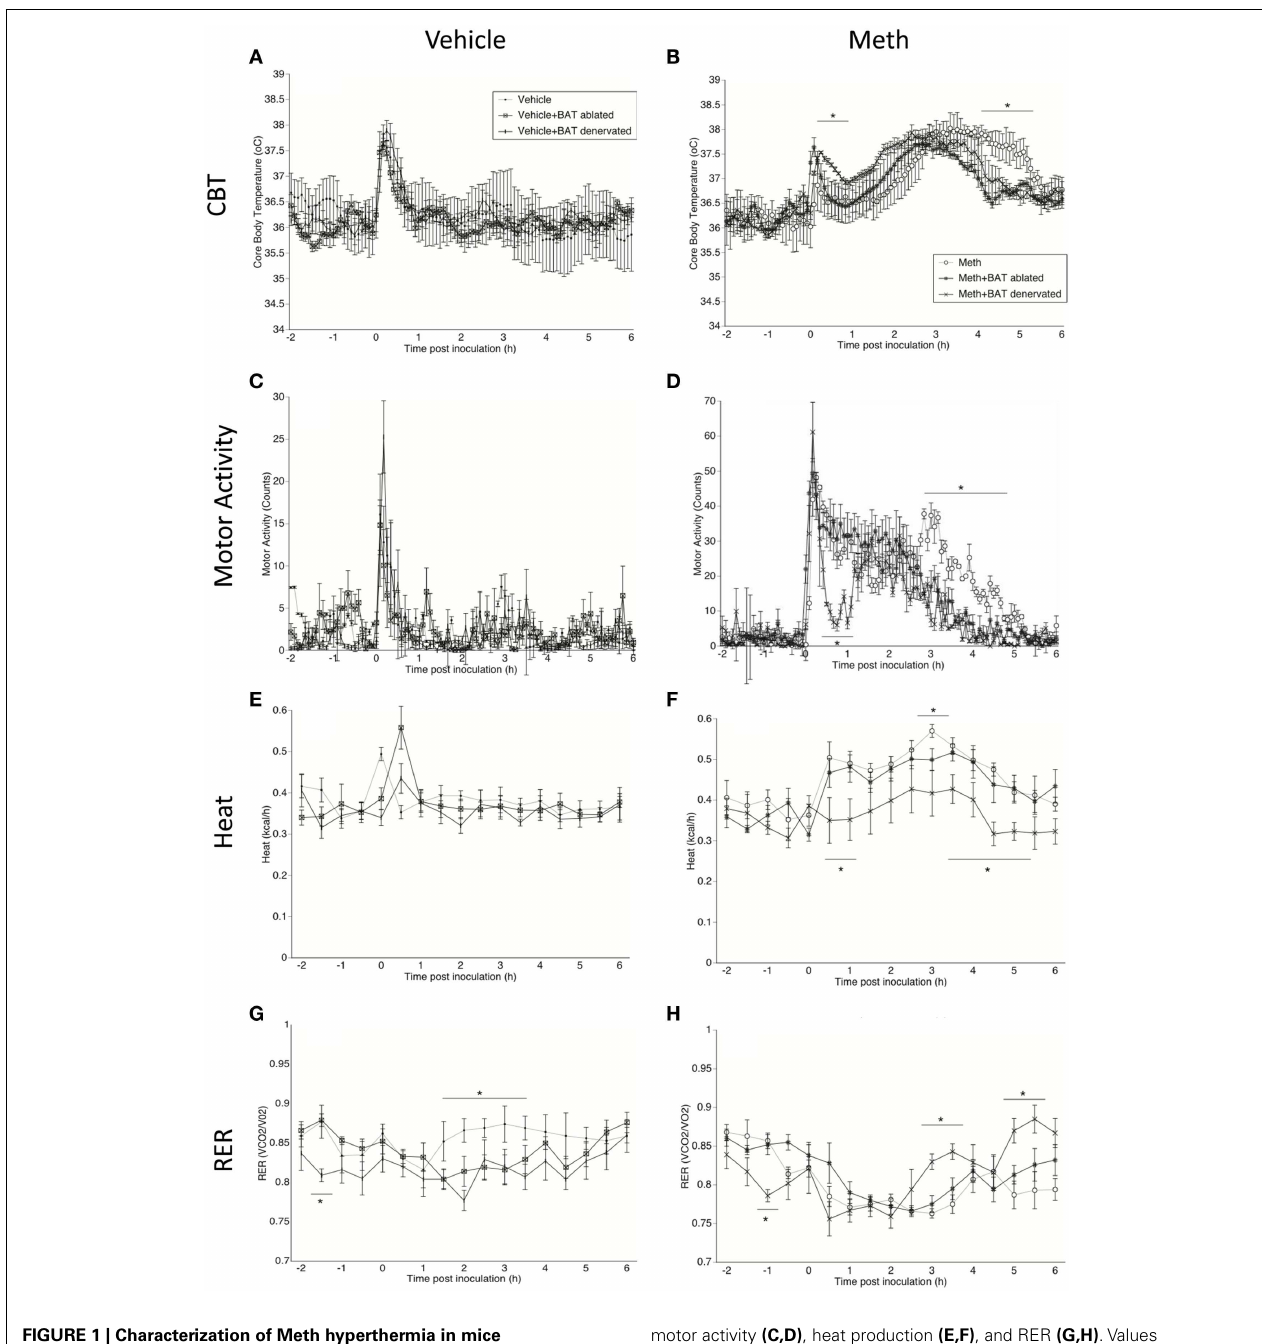
FIGURE 1 | Characterization of Meth hyperthermia in mice following a single injection of Meth and the contribution of BAT. Mice implanted with telemetry devices were treated with a single IP injection ofVehicle (A,C,E,G) or Meth (3mg/kg) (B,D,F,H) , and were evaluated during 6h for core body temperature (A,B) ,